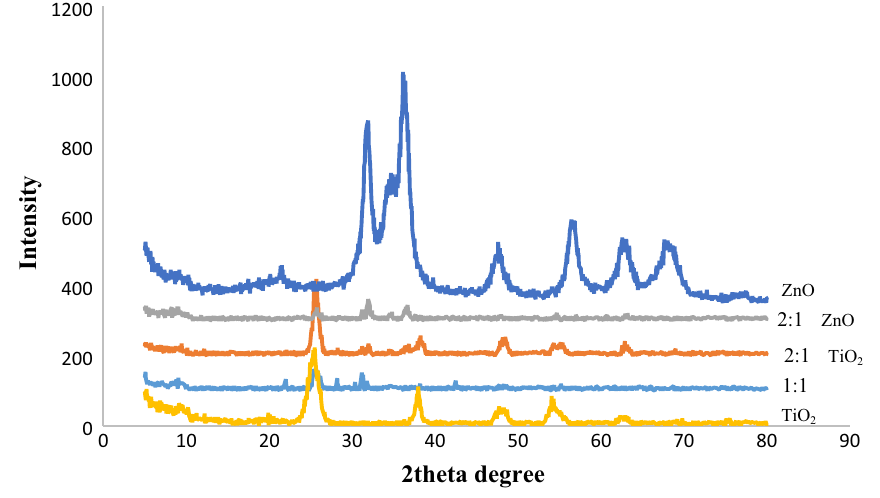
Figure 4. XRD pattern of TiO 2 quantum dots, ZnO quantum dots and TiO 2 @ZnO